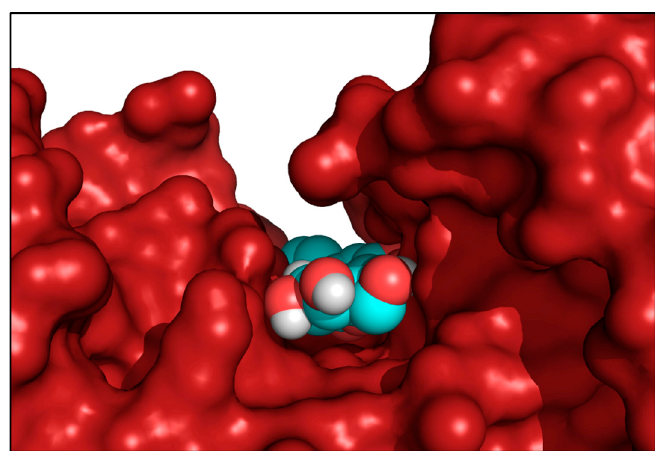
Figure 6. Side view of HEK2 active site 1 showing the bound LUT ‐ 7G molecule located by the docking procedure at the bottom of the active site crevice. The spacefill representation colored by atom type indicates the LUT ‐ 7G molecule, while the enzyme was rendered as a red solid surface. This picture was produced by using the program PyMol [27] .